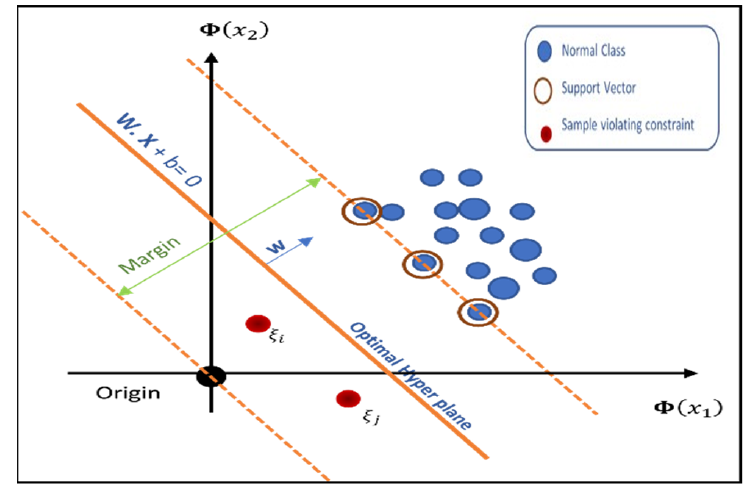
Figure 5. Conceptual model showing the application of OCSVM for outlier detection.